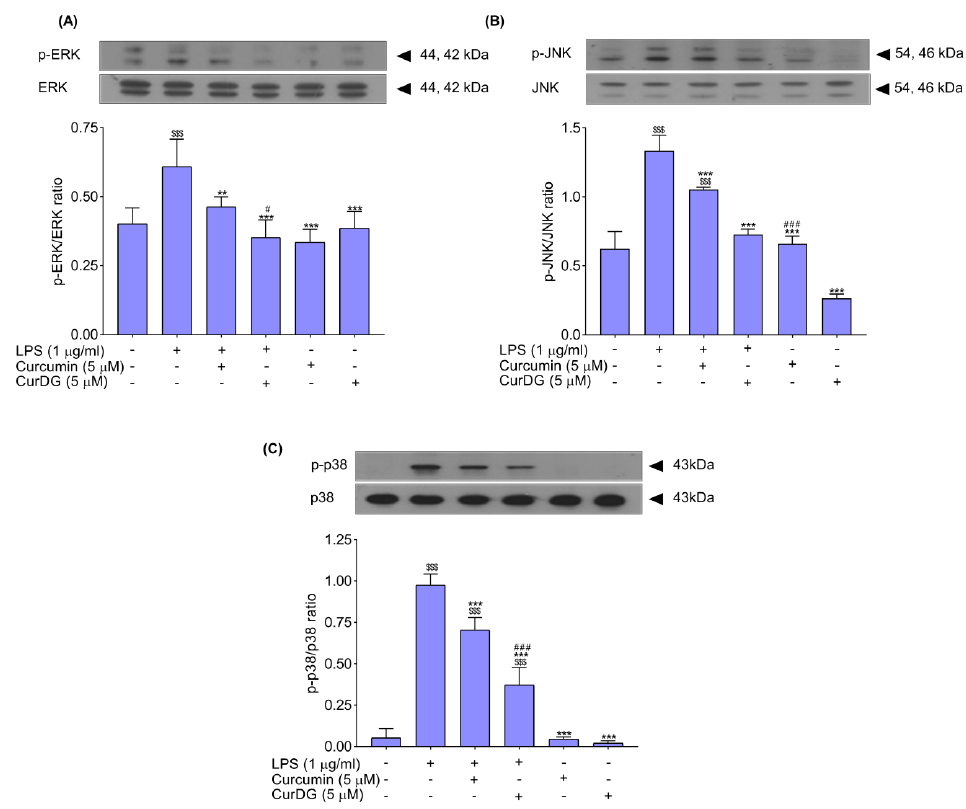
Figure 4. E ff ects of curcumin and CurDG on the expression of p-ERK ( A ), p-JNK ( B ), and p-p38 ( C ) in LPS-stimulated RAW 264.7 cells. Cells were co-treated with curcumin and LPS or CurDG and LPS for 24 h. The protein levels of phosphorylated and total forms of MAPKs were determined by Western blot analysis. The graphs were analyzed using the ImageJ software, and data show the mean ± SD of three independent tests. Phosphorylation levels of ERK1 / 2, JNK, and p38 were normalized with total levels of ERK1 / 2, JNK, and p38 densitometric values, respectively. Note: $$$ p < 0.001 compared to the control group; ** p < 0.01 and *** p < 0.001 compared to the LPS-stimulated group; # p < 0.05 and ### p < 0.001, significant di ff erences between curcumin- and CurDG-treated groups.